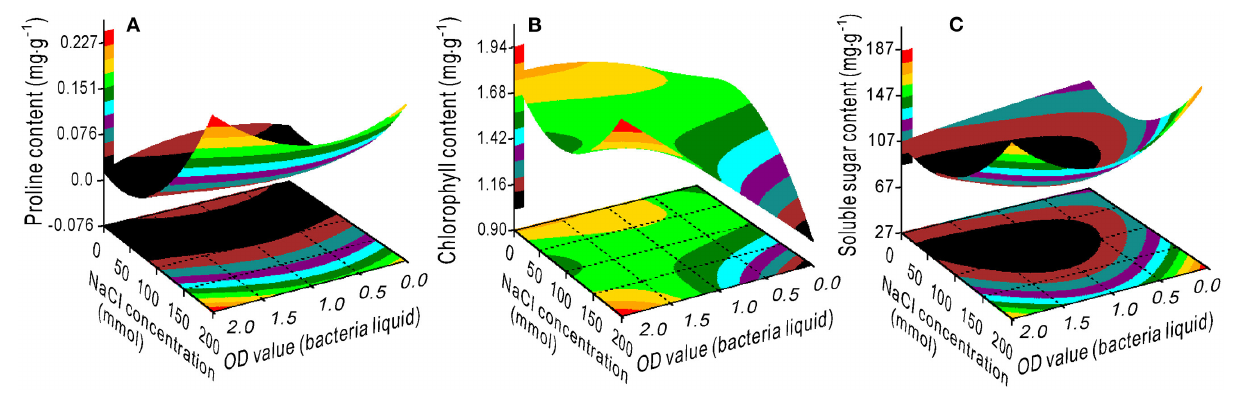
FIGURE 1 | Response surface plots showing the interaction effects on the proline (A) , chlorophyll (B) , and soluble sugar (C) contents in the switchgrass by the NaCl concentration and bacterial